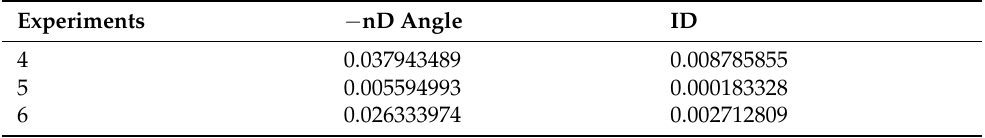
Table 16. Closeness − nD angle and